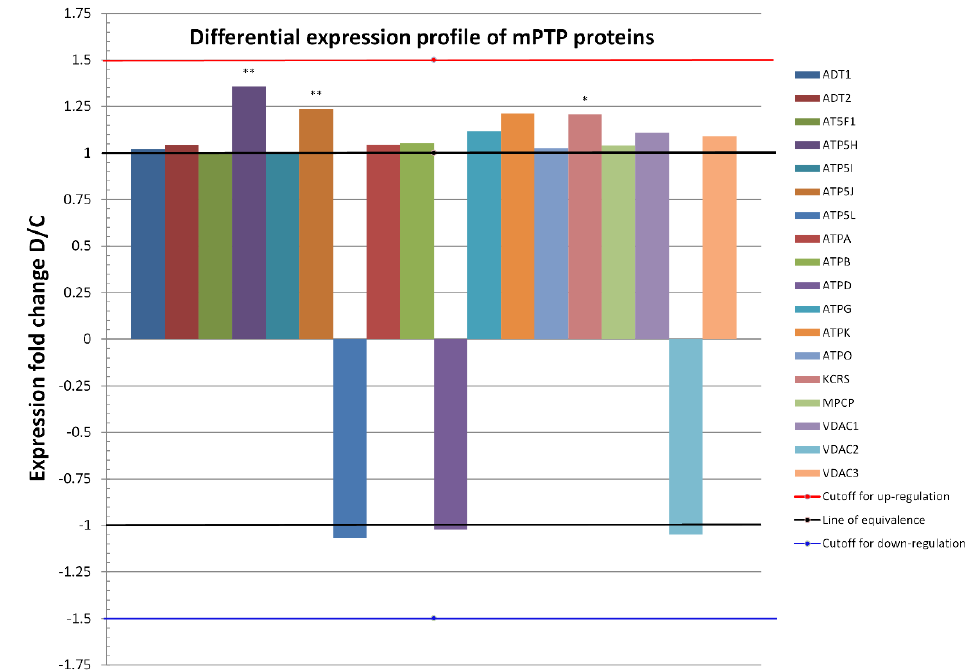
Figure 3. Differential expression profiles of 18 proteins common to both conditions (D and C) in heart mitochondria proteomes. Only proteins that changed in the relative abundance of D to C by at least 1.5-fold (red line), or by − 1.5 if expressed as 1 / FC = C / D (blue line), were considered as a biologically significant change. Fold changes for the most abundant mPTP proteins, namely, ATPA, ATPB, ATD1, and ATP5H (c.f., Bland–Altman plot), were not significant, except for the latter protein which was significantly upregulated after metabolic preconditioning. On the whole proteome level, 15 upregulated proteins out of 18 proteins (83.3%, exact Clopper-Pearson 95% confidence interval = 58.6% to 96.4%) were identified under the D condition and 3 (16.7%, 95% confidence interval = 3.6% to 41.4%) were identified under the C condition. A binomial test yielded a p -value of 0.0075, denoting a statistically significant overall upregulation under the D condition in comparison with controls. * p ≤ 0.05, ** p ≤ 0.01 compared to C.